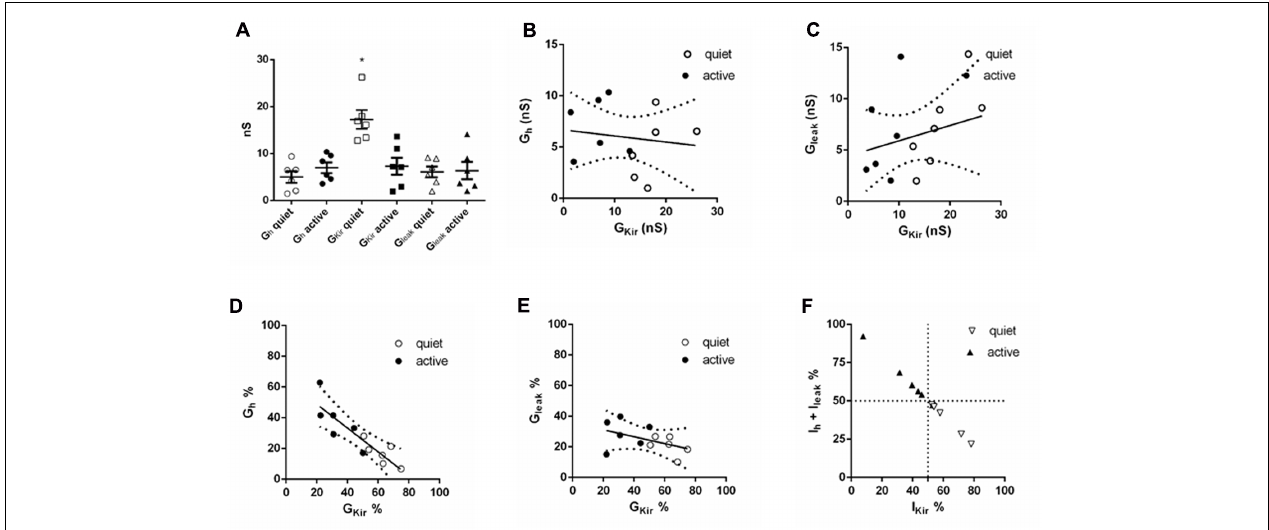
FIGURE 9 | Comparison of subthreshold conductances in the same neuron. (A) Individual values of g h , g Kir and g leak in six quiet and six active neurons. ∗ p < 0.05, unpaired t -test (compared with g Kir active). (B) Correlation of g h with g Kir ; r 2 = 0.02, p = 0.66. (C) Correlation of g leak with g Kir ; r 2 = 0.07, p = 0.39. (D) Correlation of g h % with g Kir % ; r 2 = 0.77, p = 0.0002. (E) Correlation of g leak% with g Kir% ; r 2 = 0.22, p = 0.12. (F) Distribution of quiet and active neurons regarding to the proportion of g h + g leak with g Kir